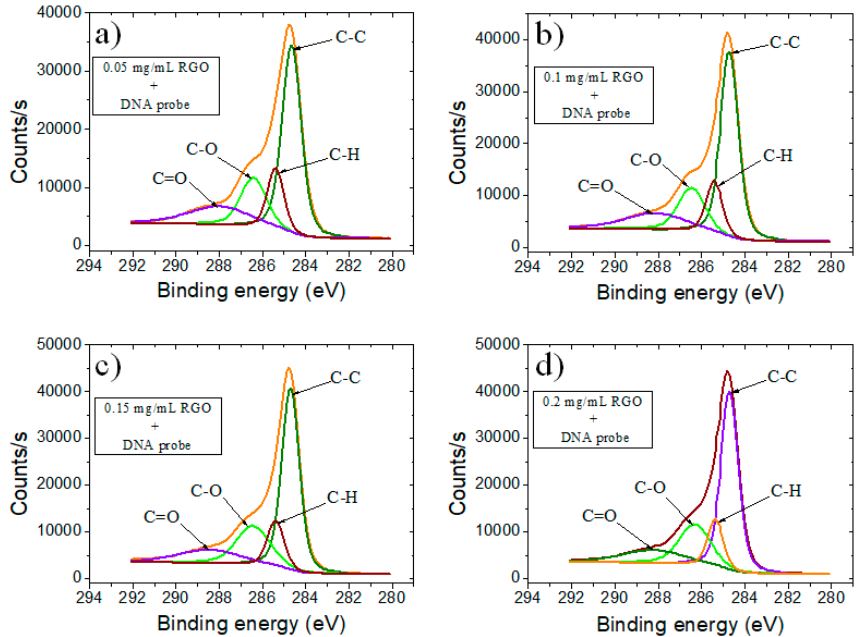
Figure 4. High-resolution C1 XPS spectra of SPCE modified with RGO using as precursor ( a ) 0.05